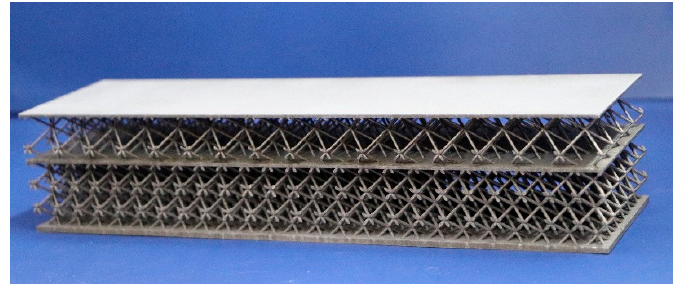
Figure 1. Bi-layer lattice-filled sandwich structure by additive manufacturing [28].